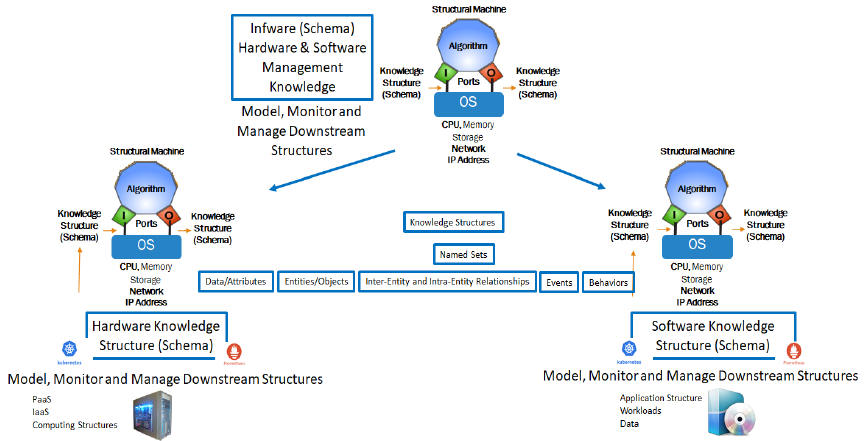
Figure 9 . Schema managing infware, hardware, and software for the deployment, con- figuring, monitoring, and managing distributed application workloads on cloud re- sources